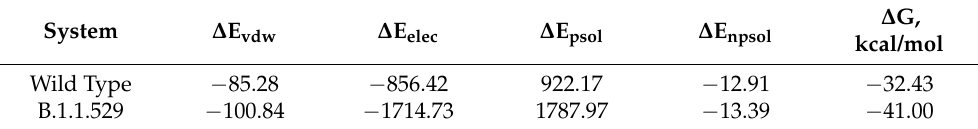
Table 1. Binding free energies of the Omicron spike RBD and hACE2 complex.